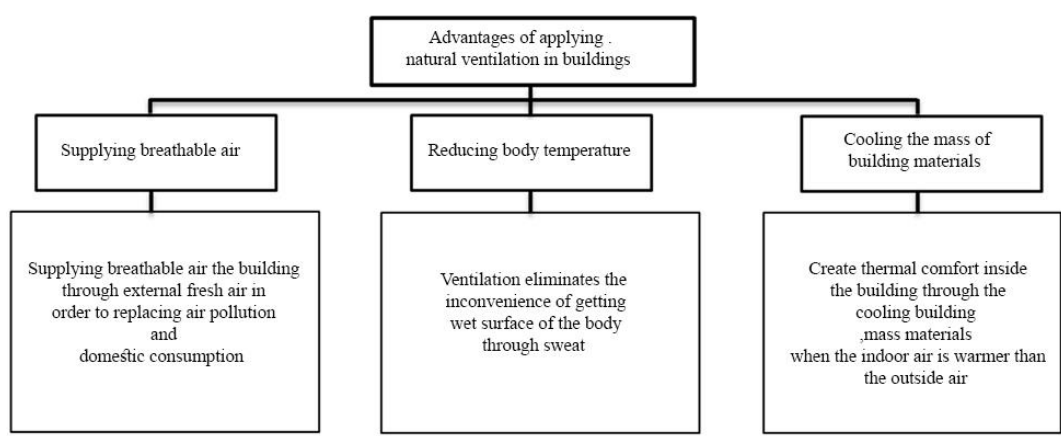
Figure 8. Terrace in Tabib’s and Nozari’s houses for shading. Buildings 2018 , 8 , x FOR PEER REVIEW